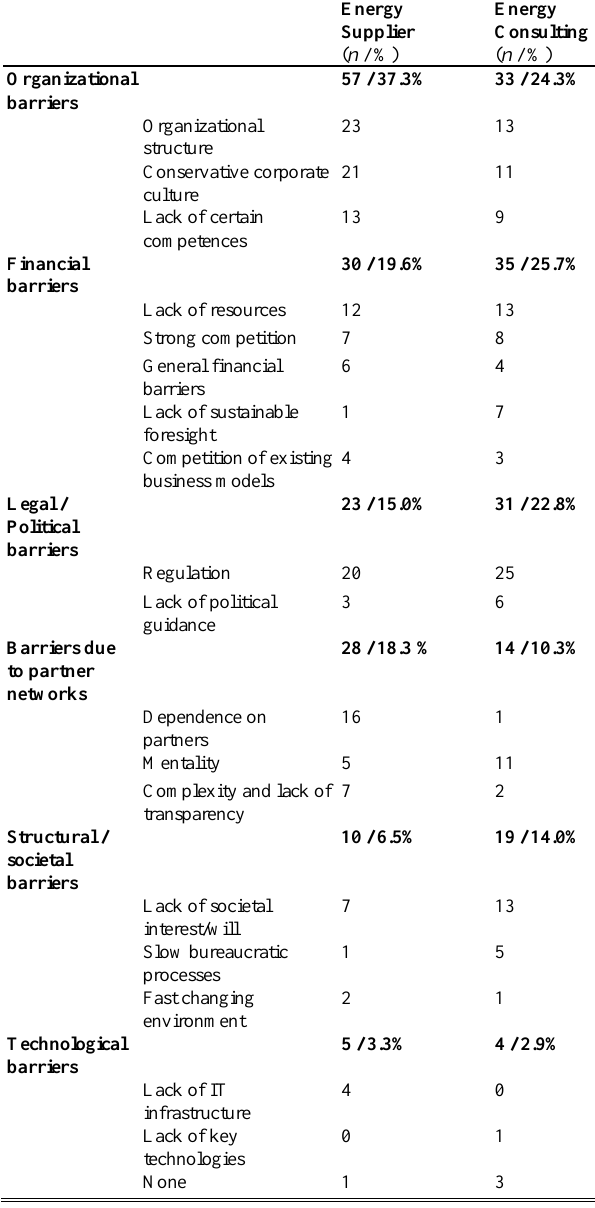
Table 1 . Main barriers with their subcategories ( n = the number of mentions of the specific barriers category by experts of the respective group, % = percentage share of the upper category in the total number of named barriers by the respective